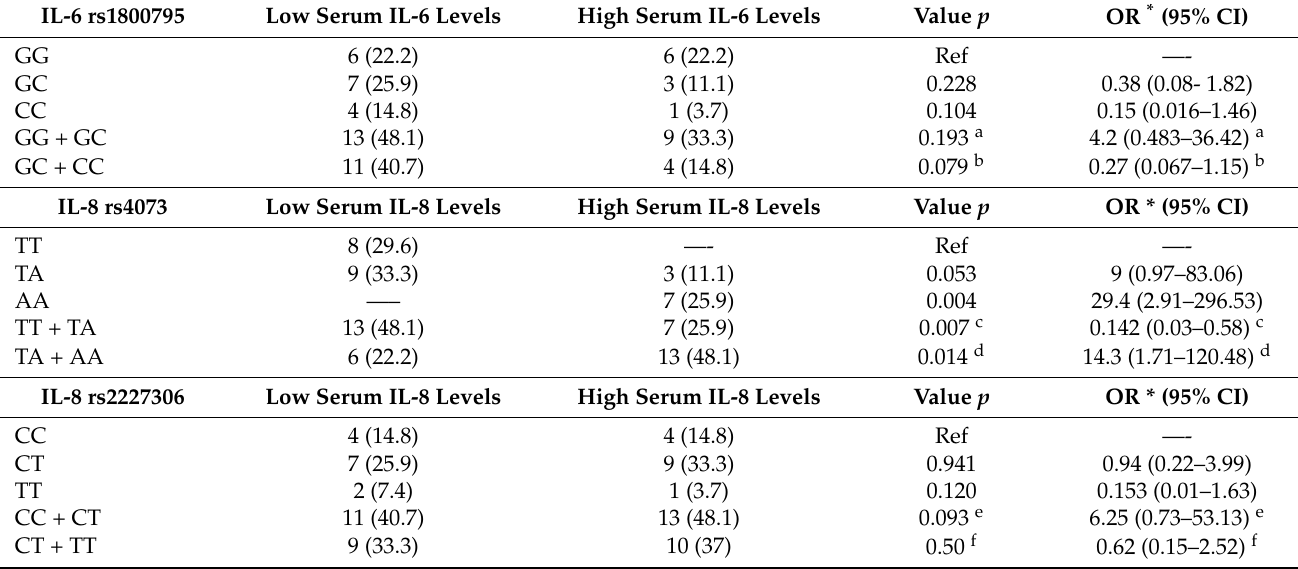
Table 8. Association of the SNP genotype IL-6 rs1800795 and IL-8 rs4073/rs2227306 with serum levels of IL-6 and IL-8 in NB